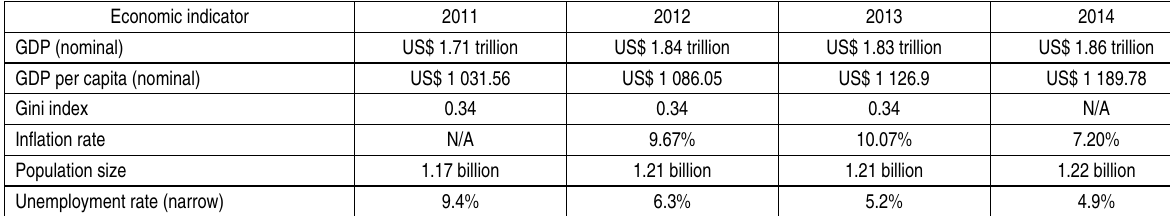
Table 3. Economic indicators of the Indian